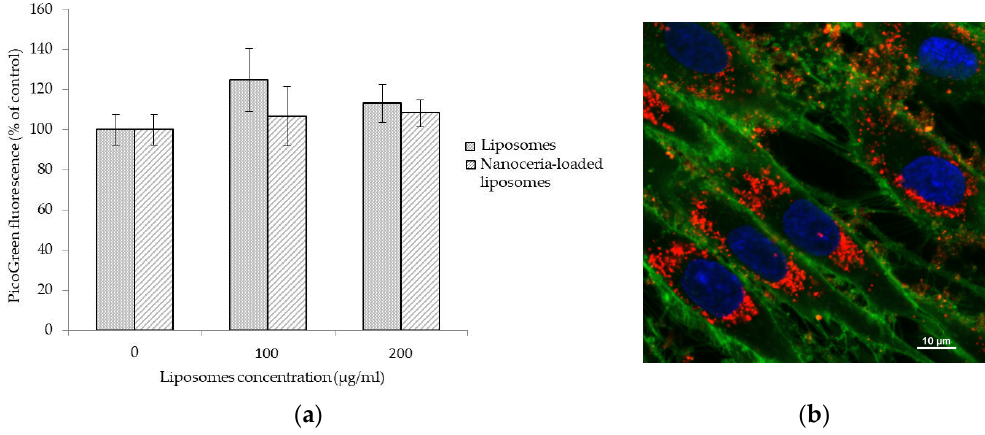
Figure 2. PicoGreen assay on NHDF cells after 48 h of incubation with increasing concentrations of empty liposomes and nanoceria ‐ loaded liposomes ( a ); confocal image showing nanoceria ‐ loaded liposomes (in red) up ‐ taken by NHDF cells after 48 h of incubation; nanoceria ‐ loaded liposomes are stained in red, cell membranes in green, and nuclei in blue ( b ).